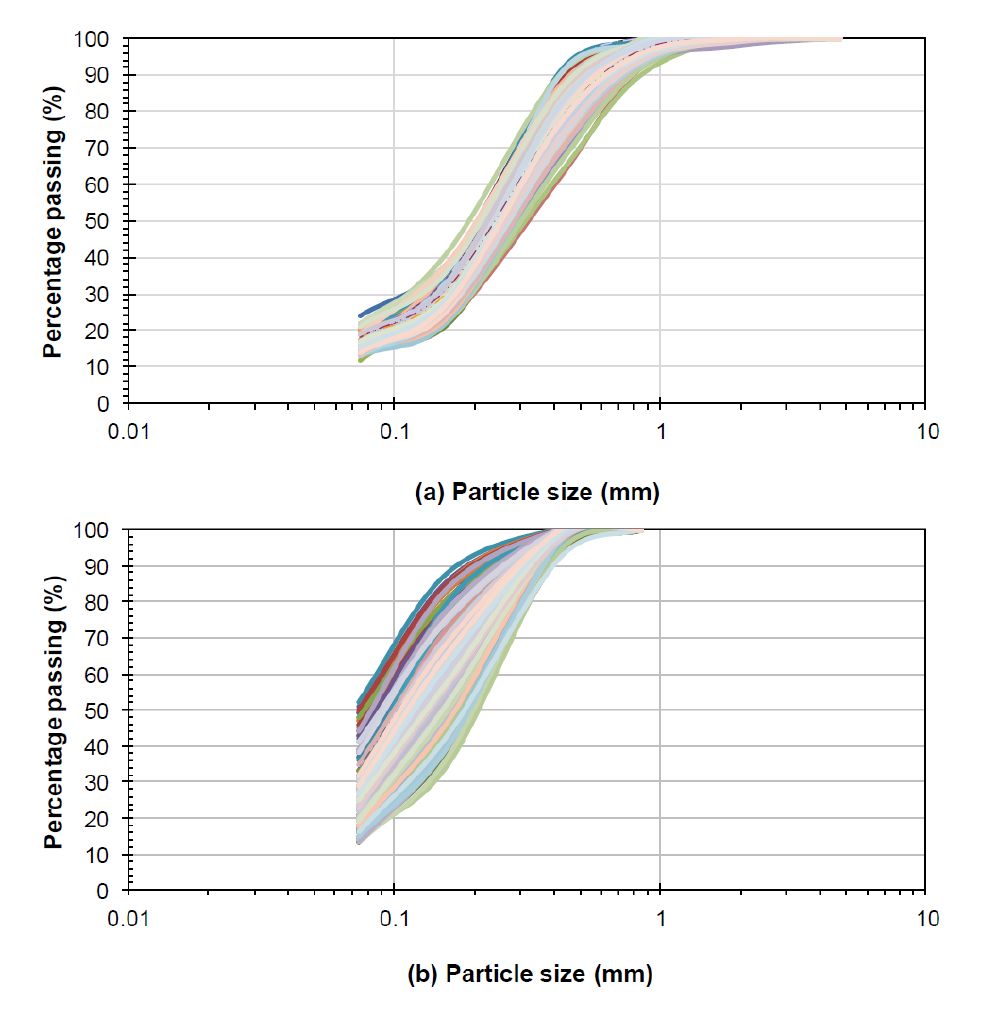
Figure 2. Variation of the particle size distribution (PSD). Operational control of two sand tailings dams of medium copper mining in Chile. ( a ) Sand tailings T1. ( b ) Sand tailings T2. (see Table